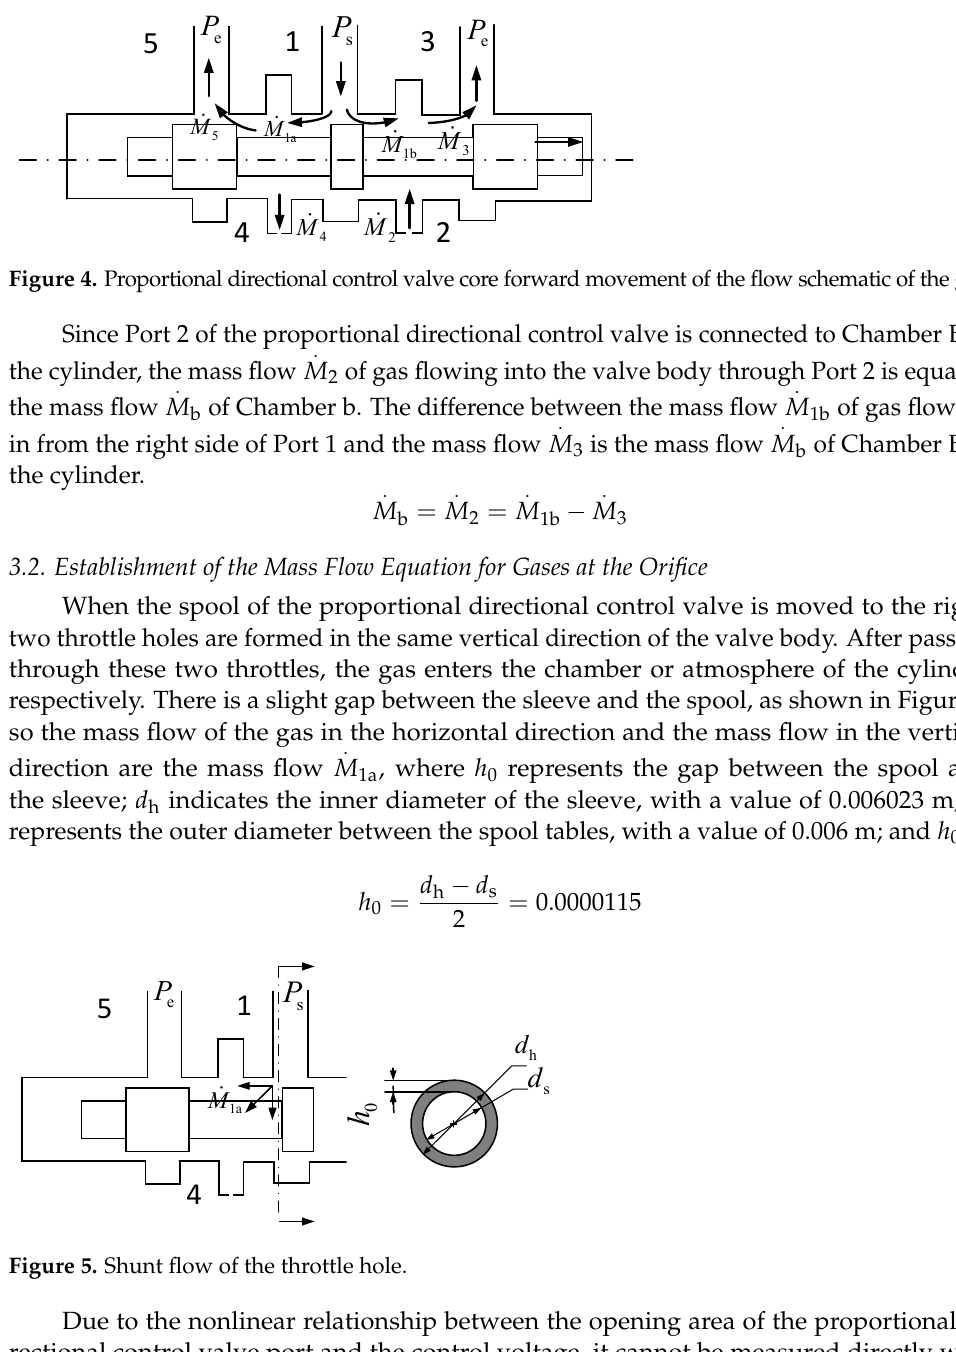
Figure 5. Shunt flow of the throttle hole. h represents the gap between the spool and the sleeve; where 0 diameter of the sleeve, with a value of 0.006023 m; tween the spool tables, with a value of 0.006 m; and